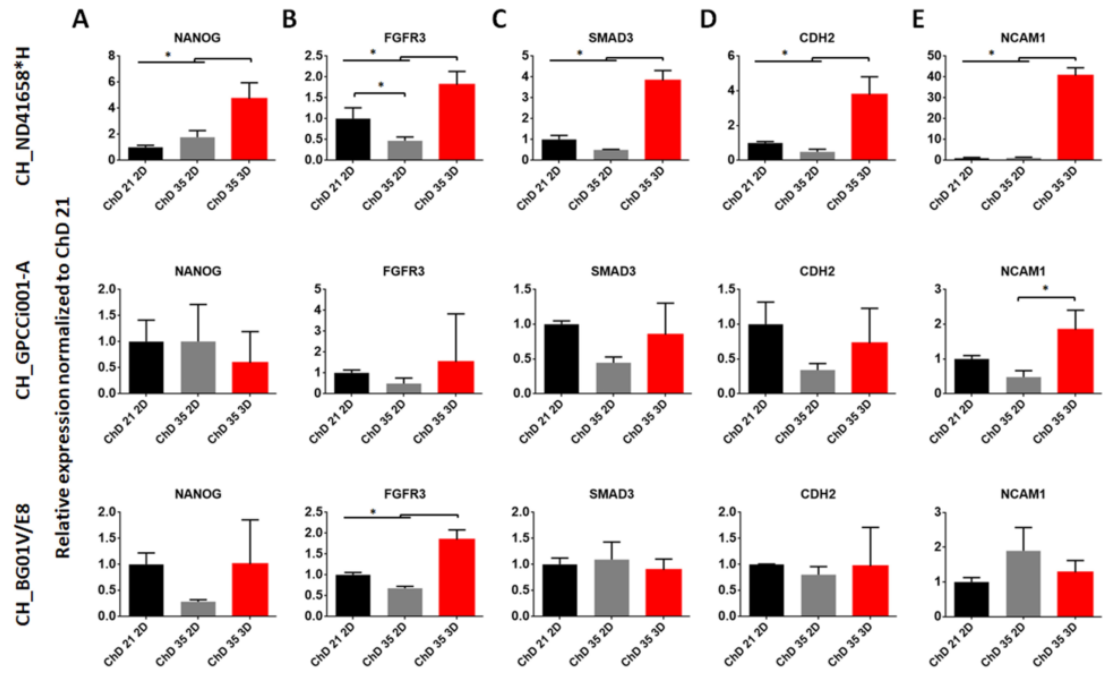
Figure 2. The effect of prolonged and 3D culture on expression of pluripotent ( A ), chondrogenic signaling pathways ( B , C ) and mesenchymal condensation ( D , E ) marker genes. RT-qPCR represents gene expression of markers specific to chondrogenesis during chondrogenic differentiation. As a control, the differentiated PSC cells at ChD 21 2D was used. The error bars represent SD from three experiments. The statistical analysis was performed using ANOVA with Tukey’s post-hoc multicomparison test (* p < 0.05). ChD—Chondrogenic differentiation; 2D—two-dimensional culture; 3D—three-dimensional culture.